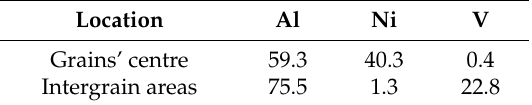
Figure 8. Micrographs (TEM) of thin films deposited onto W wires after ignition. ( a ) BF and ( b ) STEM. Point EDS analyses were conducted inside large grains, as well as at the grain boundaries. The results summarized in Table 1 indicate Al 3 Ni 2 grains with Al 3 V phase located at grain boundaries. Table 1. Average chemical composition of point TEM/EDS measurements (at.